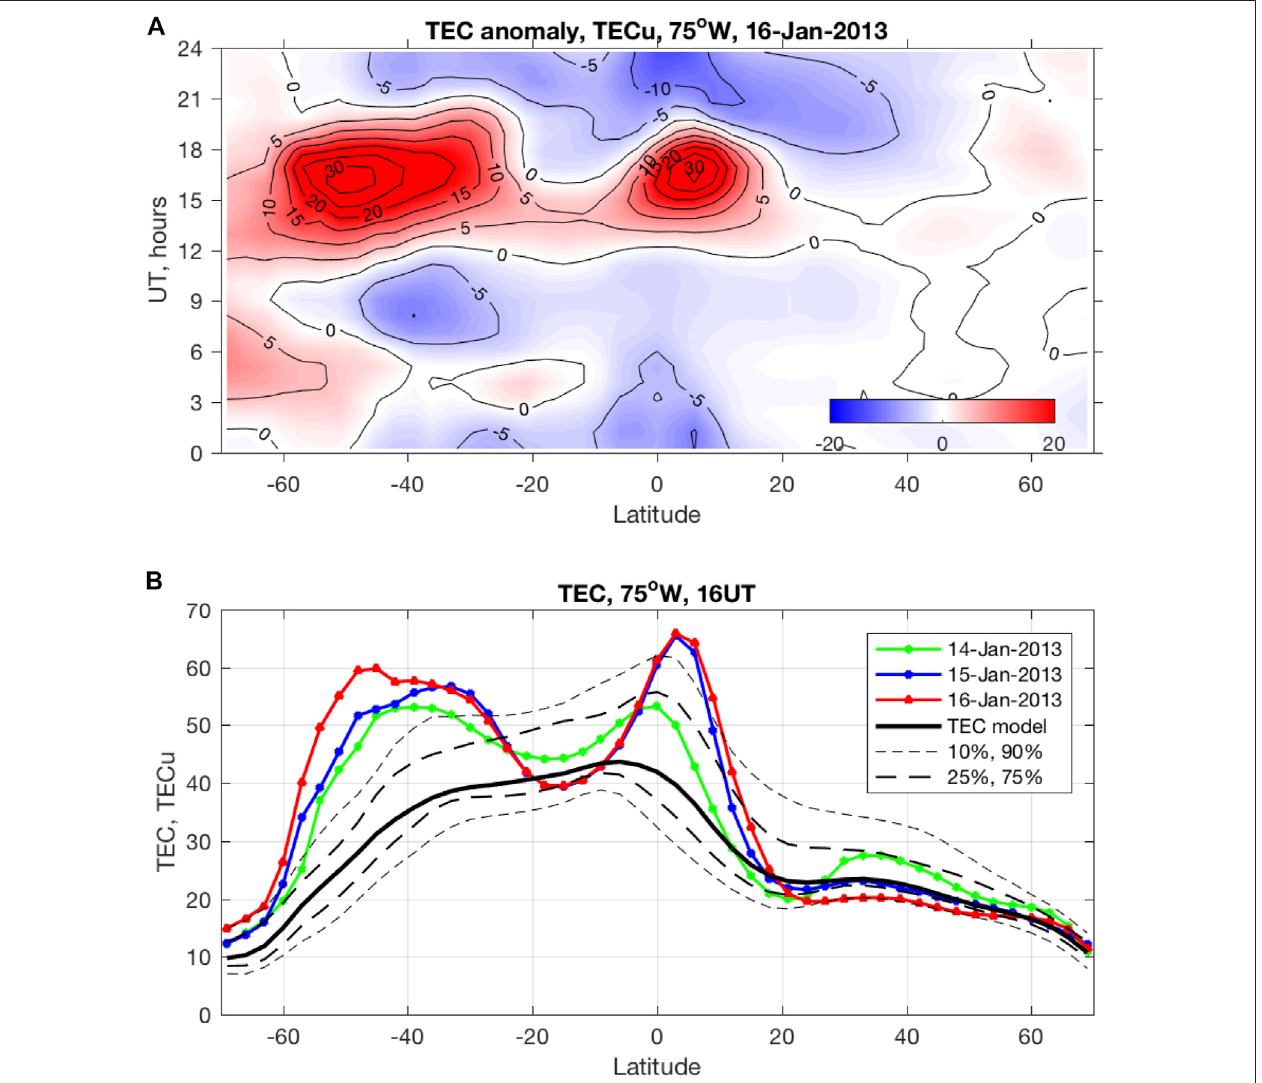
FIGURE 2 | (A) Anomaly in the total electron content at 75 ° W on Jan 16, 2013 extends from equatorial to high latitudes of the southern hemisphere. (B) TEC variation with latitude for 75 ° W and 16 UT (11 AM Local Time). Shown are TEC values observed on January 14 – 16, 2013 (green, blue, red) compared with TEC values expectedforthisseasonandsolaractivityaspredictedbytheempiricalmodel(black).Thickdashlinesshow25thand75thpercentilesofallavailabledata,thindashlines show 10th and 90th percentiles. Percentiles were calculated using TEC observations with close solar fl ux conditions (127 < F10.7 < 136) and from mid-December to mid-February.